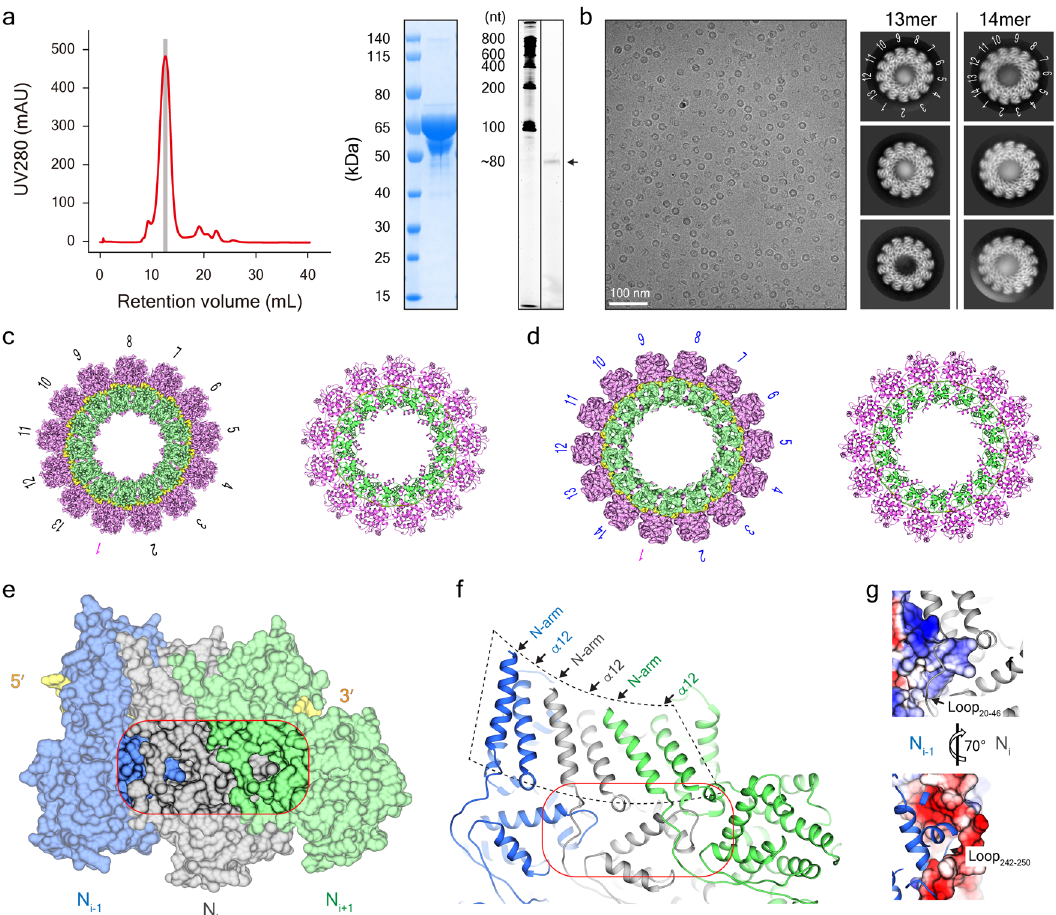
Fig. 1 MuV N-RNA rings in different protomers. a Gel fi ltration chromatography of MuV nucleoproteins (left) and the respective analysis of SDS-PAGE gel (middle) and RNA gel (right). b A typical cryo-EM image of MuV N-RNA rings (left) and the 2D classi fi cation average galleries (right) of N ring-13p (~83% particles) and N ring-14p (~17% particles). c 3D reconstruction of MuV N ring-13p and the respective atomic model. RNA, NTD, and CTD are colored in yellow, pink and green, respectively. The same color code is used for the rest of the fi gures unless speci fi ed. d 3D reconstruction of MuV N ring-14p and the respective atomic model. e , f Domain swapping and the detailed structural analysis on the N-arm and N-hole in MuV N-RNA rings. g The electrostatic interaction between Loop 242 – 250 from N i-1 and the N-hole from N i